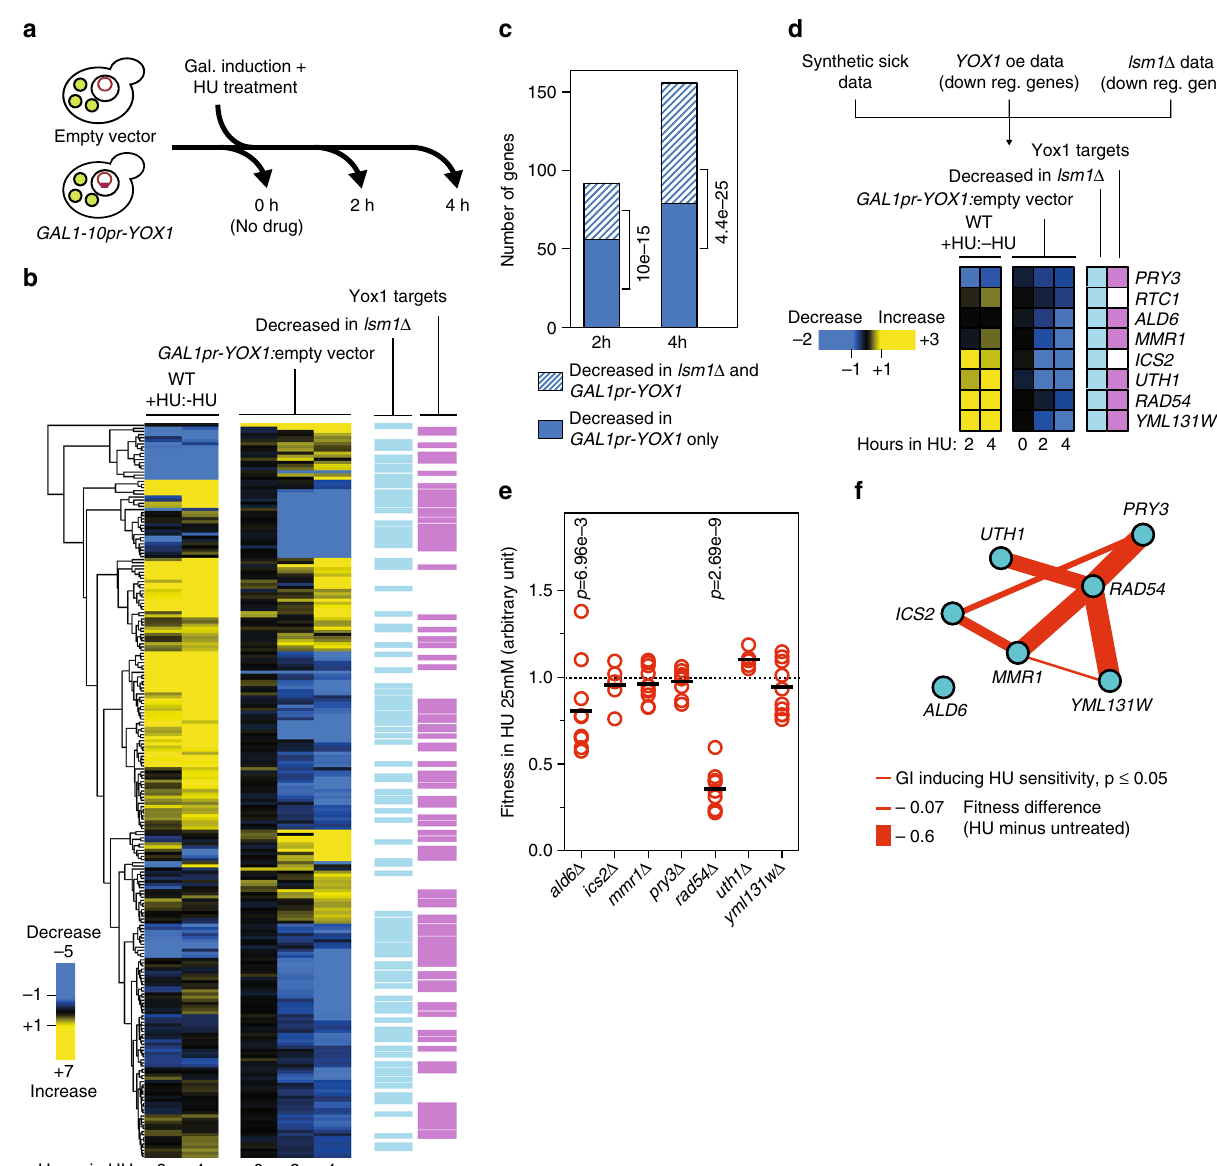
Fig. 6 Excess Yox1 represses genes that are critical for cell fi tness during replication stress. a Overview of the RNA-seq experiment. WT cells containing pBY011 (empty vector) or pBY011- YOX1 ( GAL1-10pr-YOX1 ) vectors were cultivated in synthetic media containing raf fi nose. Overexpression of YOX1 was induced by adding galactose and replication stress was induced by HU treatment. RNA was extracted at the indicated time points. b Heatmap of expression ratios generated by hierarchical clustering, showing genes that were differentially expressed upon YOX1 overexpression. Two different ratios are represented: +HU: − HU compares expression values in the control strain (empty vector) between the HU condition and the untreated condition, and GAL1-10pr-YOX1 :empty vector compares expression values between the YOX1 -overexpressing strain and the control strain at each time point. Light blue bars indicate genes that were downregulated after 2 h and/or 4 h in HU in lsm1 Δ compared to WT (as in Fig. 1). Purple bars denote genes that are described as Yox1 targets in the Yeastract database. c The number of genes with decreased mRNA abundance upon YOX1 overexpression, with the overlap of genes that also have decreased mRNA abundance in lsm1 Δ is plotted as a stacked bar graph. The indicated P -values were calculated using a hypergeometric test. d Identi fi cation of potential Yox1 targets during replication stress at the intersection of three datasets. Heatmaps are as presented in b . e Fitness data in HU for the single mutants identi fi ed in d . Each data point represents a single replicate ( n = 5). Horizontal bars represent the average of the replicates. P -values are from a Student ’ s t -test. f Condition-dependent negative genetic network of interactions between the 8 targets in d . Red edge thickness is proportional to the difference between the double mutant fi tness in absence and presence of 25 mM